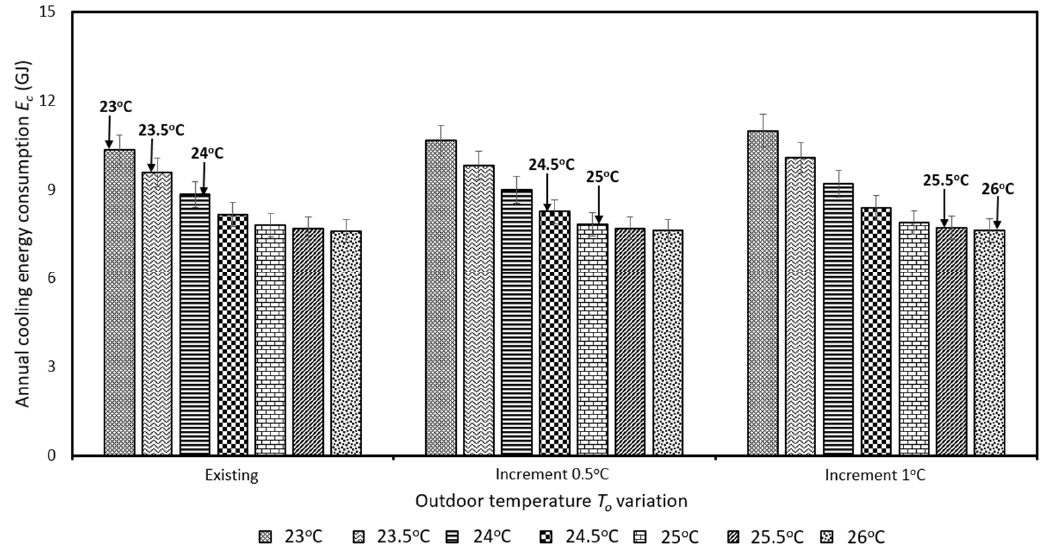
Figure 10. Annual cooling energy consumption forecast based on indoor set-point temperature.